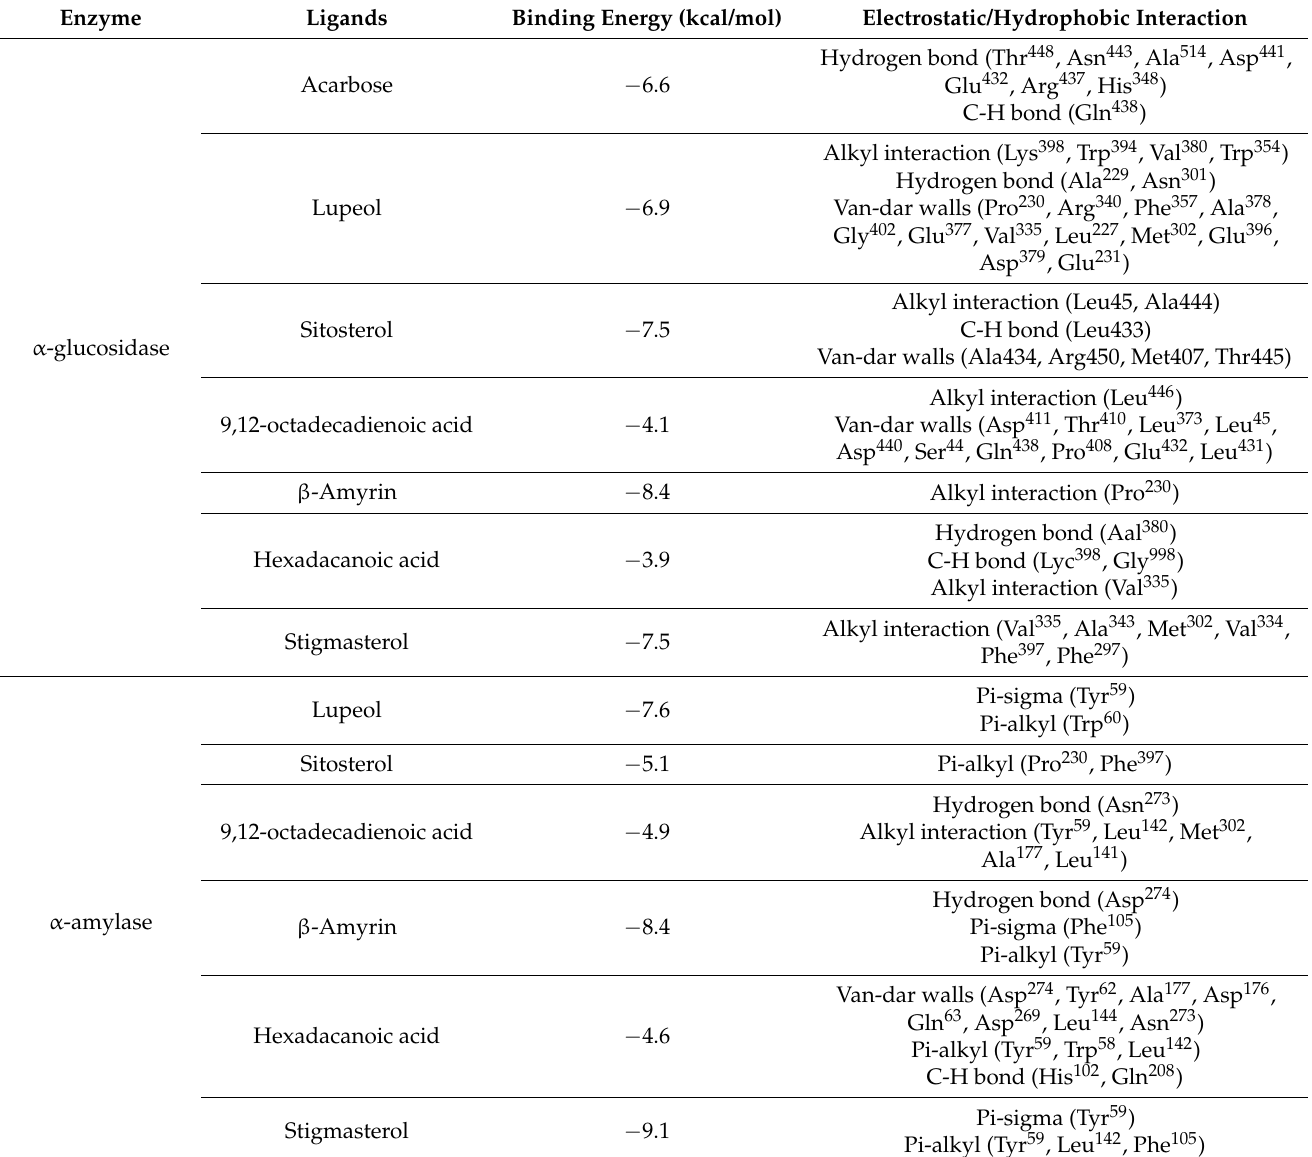
Table 7. Binding affinities and interactions of ligands against (anti-diabetic)